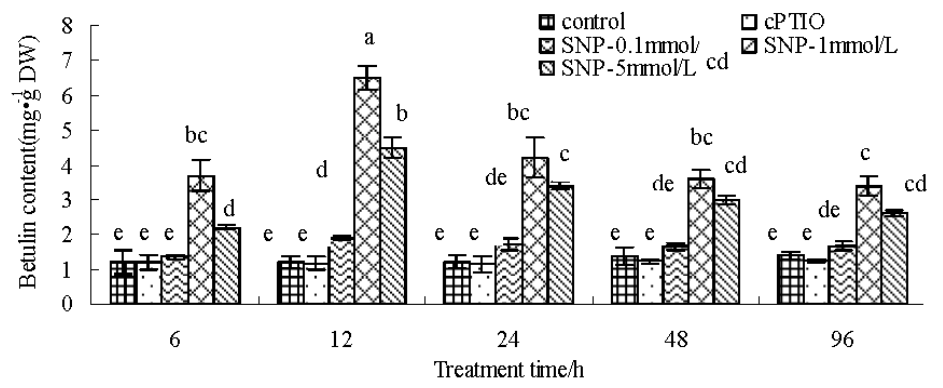
Figure 1. Effect of SNP on betulin production in birch suspension cells. The letter explained the difference of data from statistical level. ( p < 0.05, Tukey’s test).